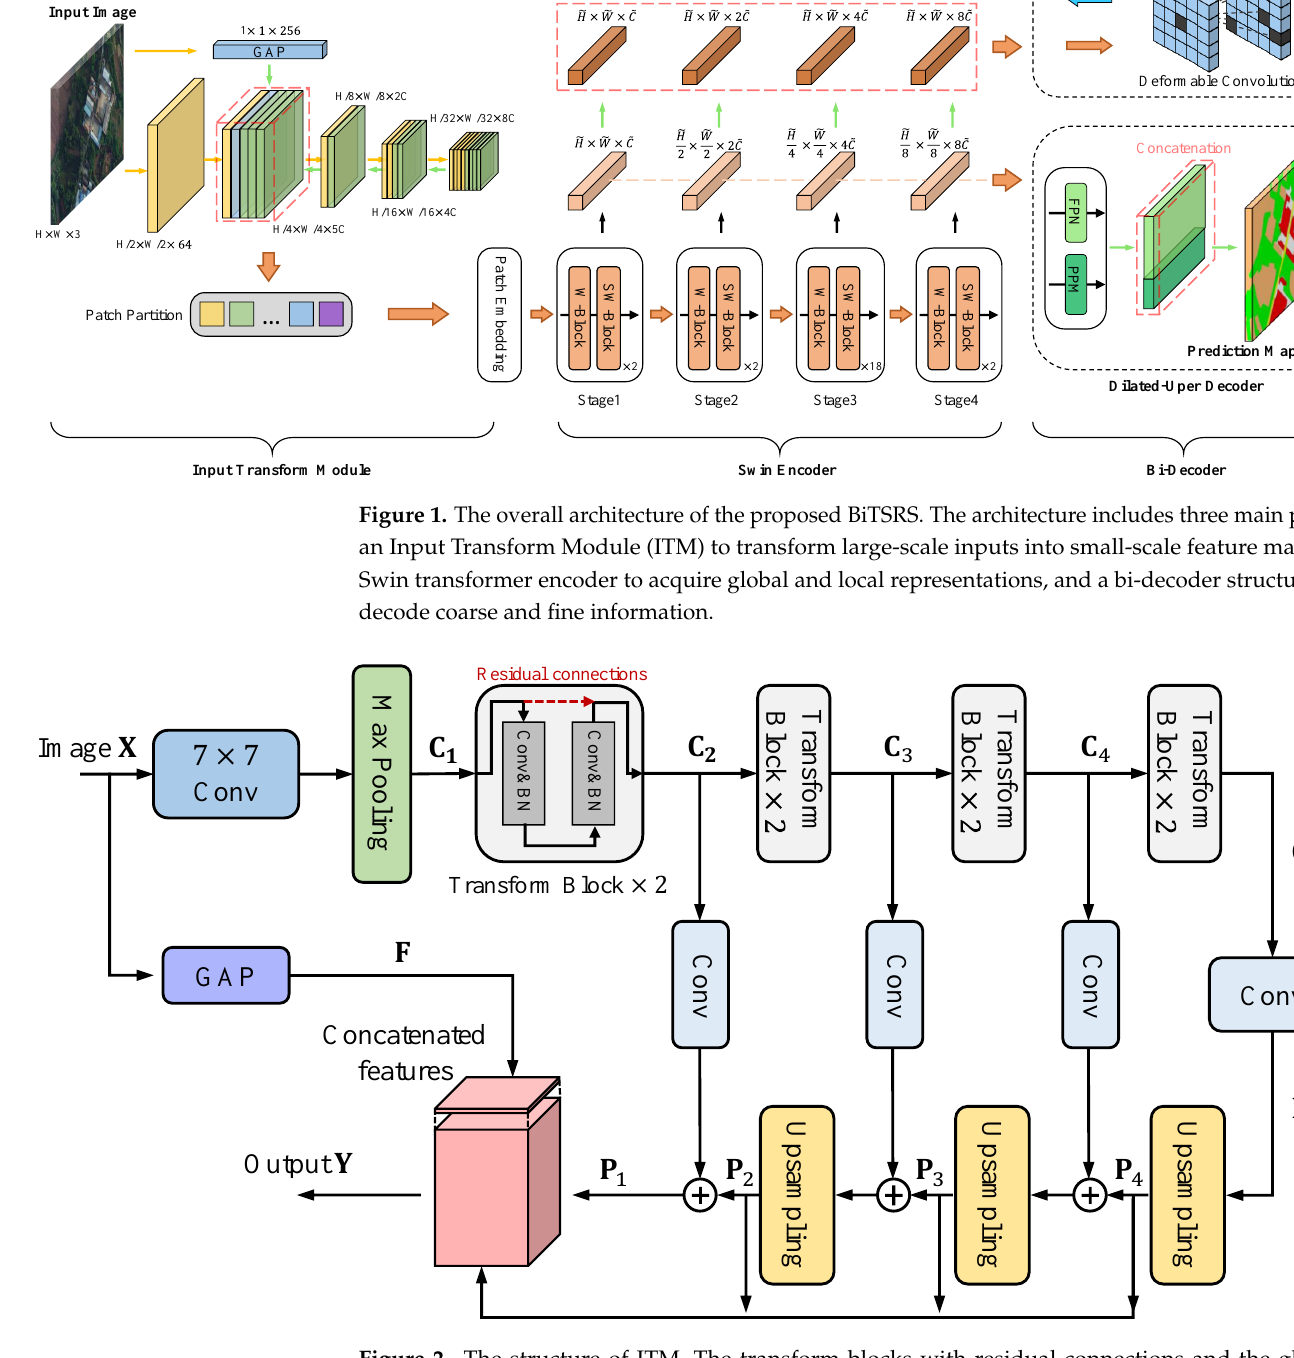
Figure 2. The structure of ITM. The transform blocks with residual connections and the global average pooling (GAP) are used to preserve the original